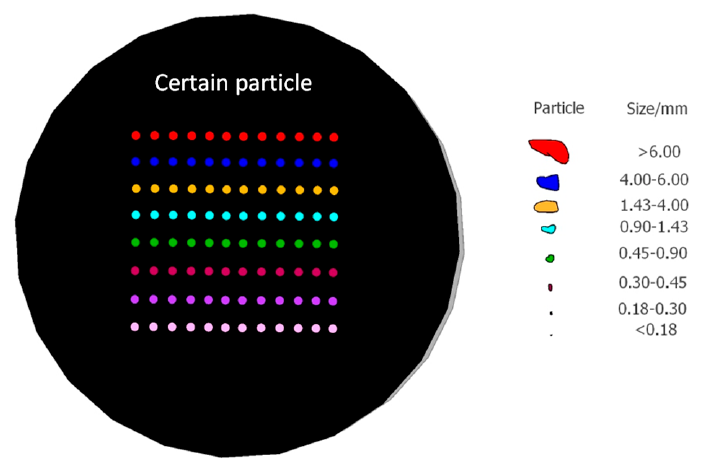
Figure 5. Spectral acquisition of standard samples.